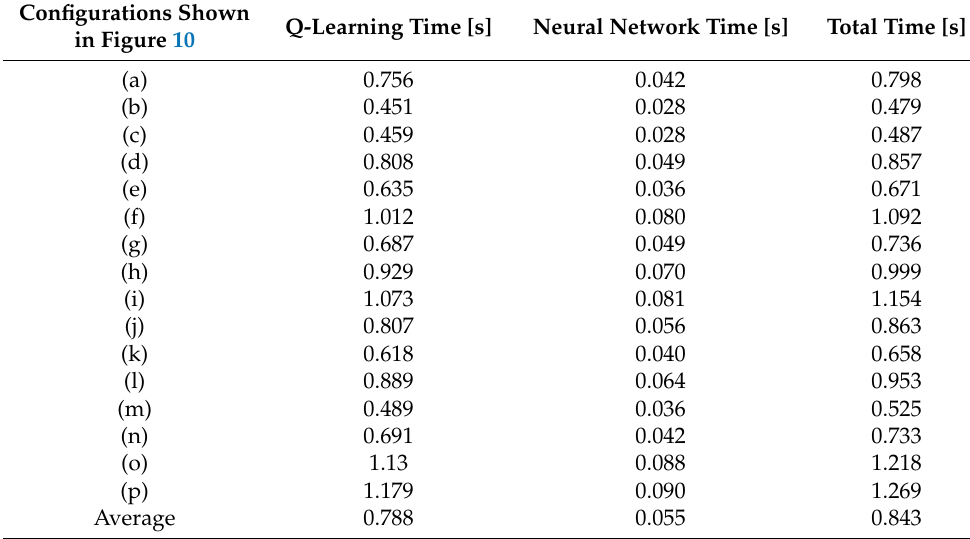
Figure 10. ( a – p ) Different configurations with their paths: blue arrows represent the sequence of actions in each cell from the start cell to the target cell. Table 3. Result of running time test for different configurations in the 8 by 4